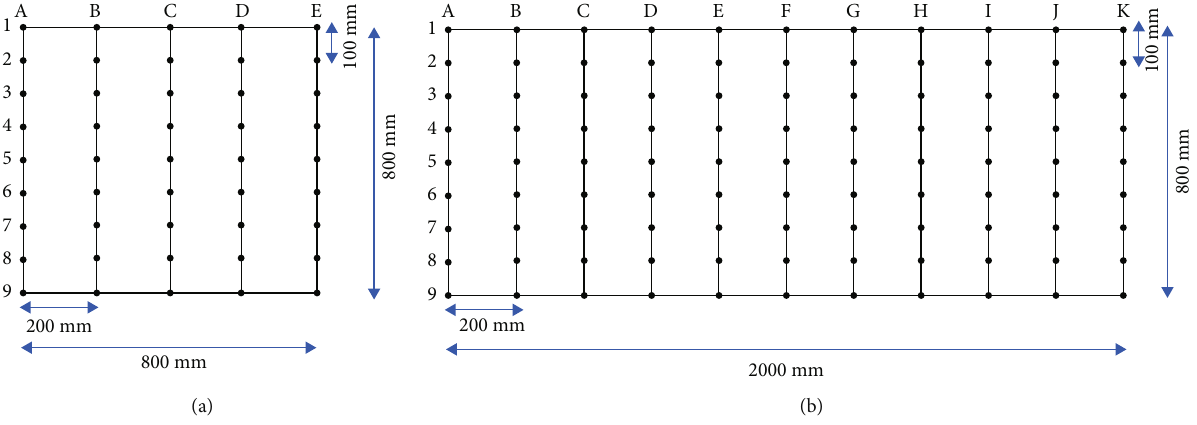
Figure 3: (a) Saddle roof measuring points. (b) Arched and wavy roof measuring points. The spacing between measuring points is